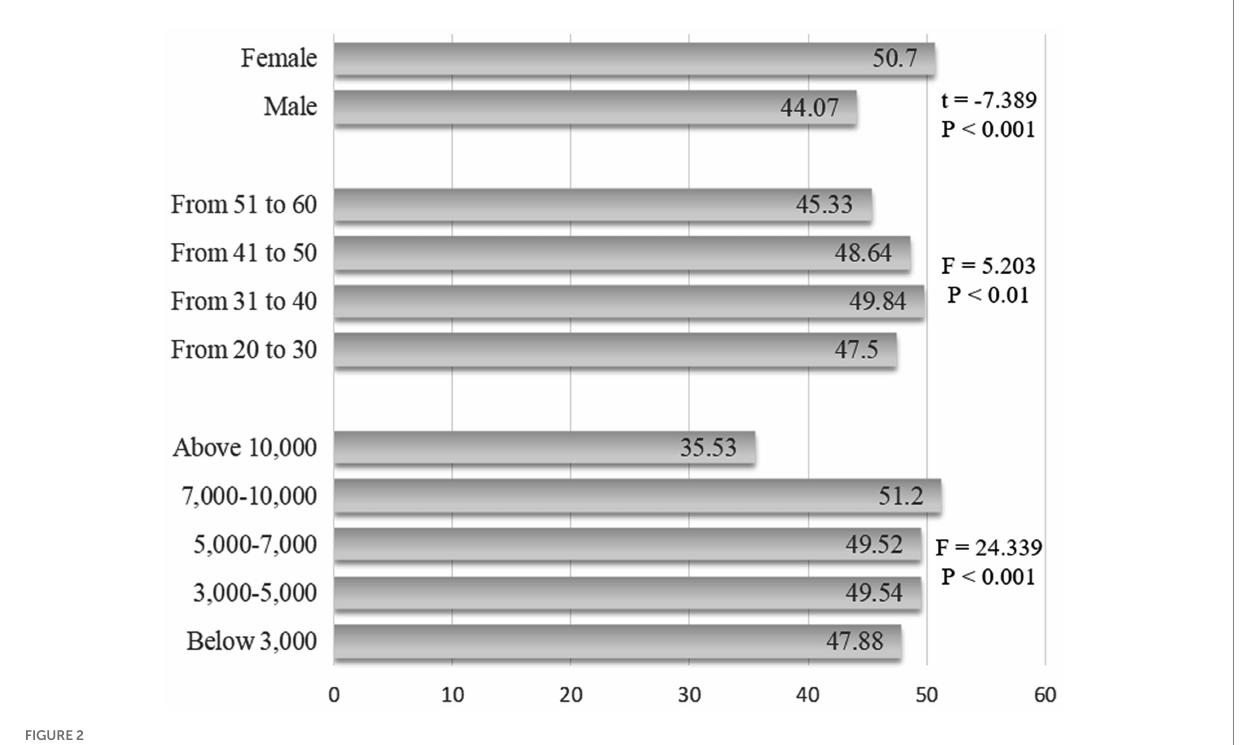
FIGURE 2 Differences in social anxiety across demographic